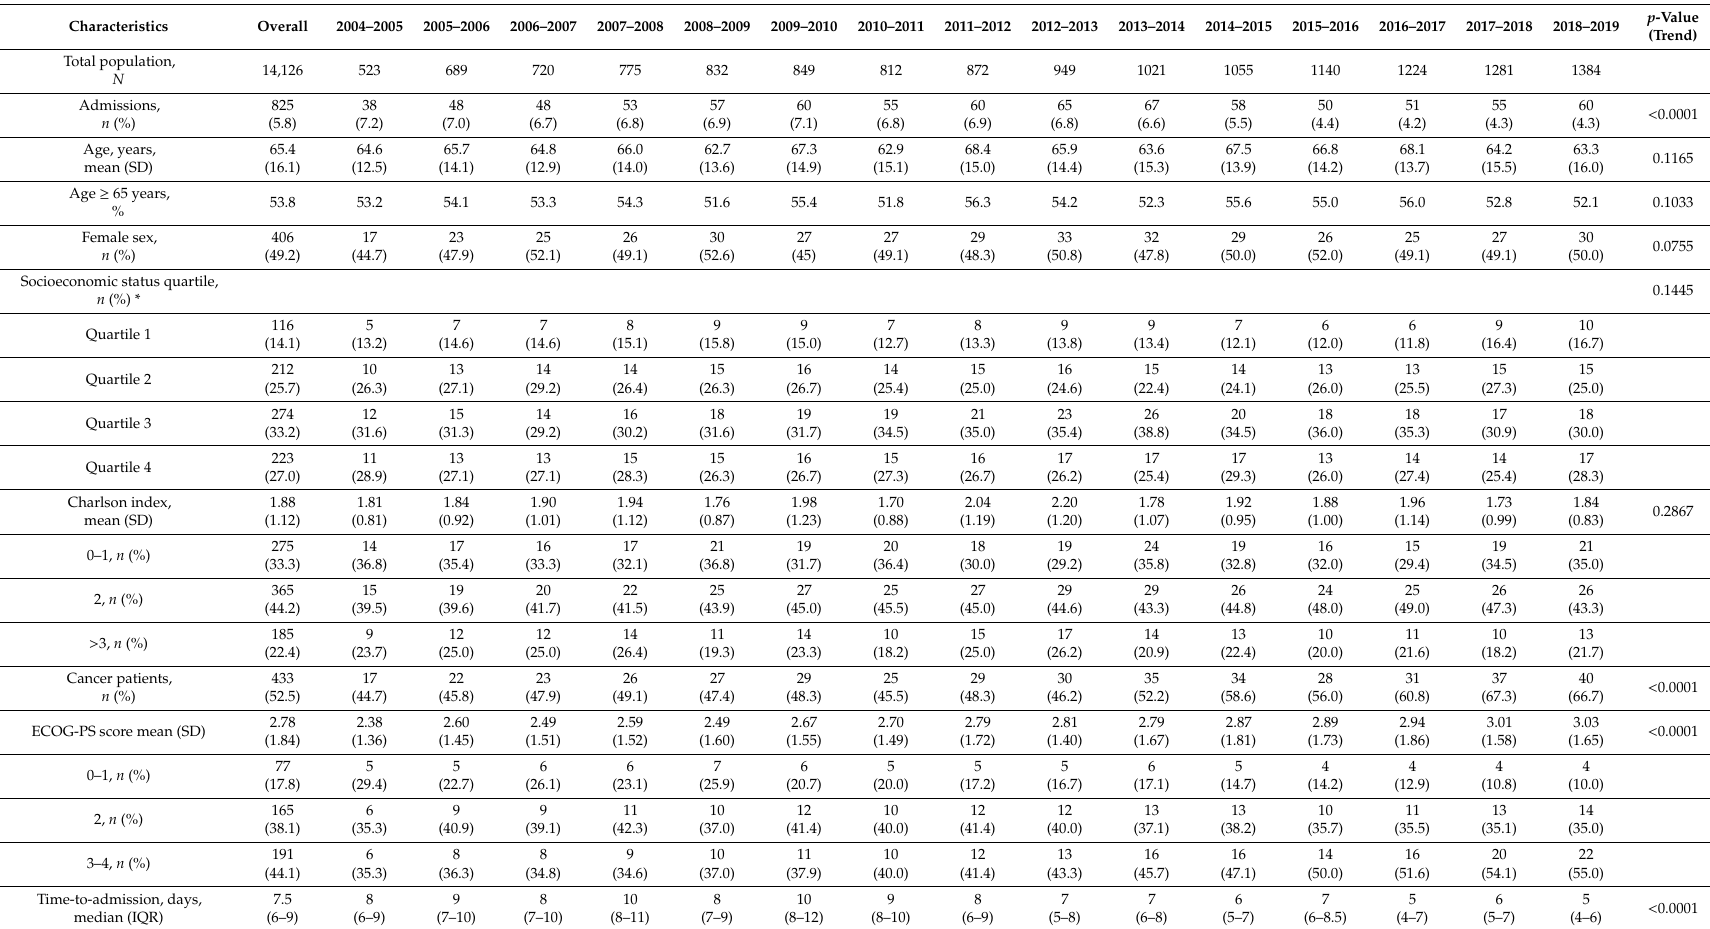
Table 1. Trends in characteristics for patients hospitalized from 2004 to